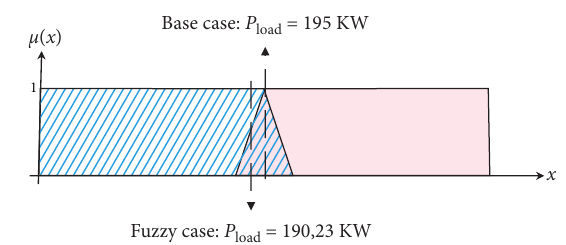
Figure 17: Comparison between the used power in the base scenario and the scenario considering the load fuzziness (at the 7 th time